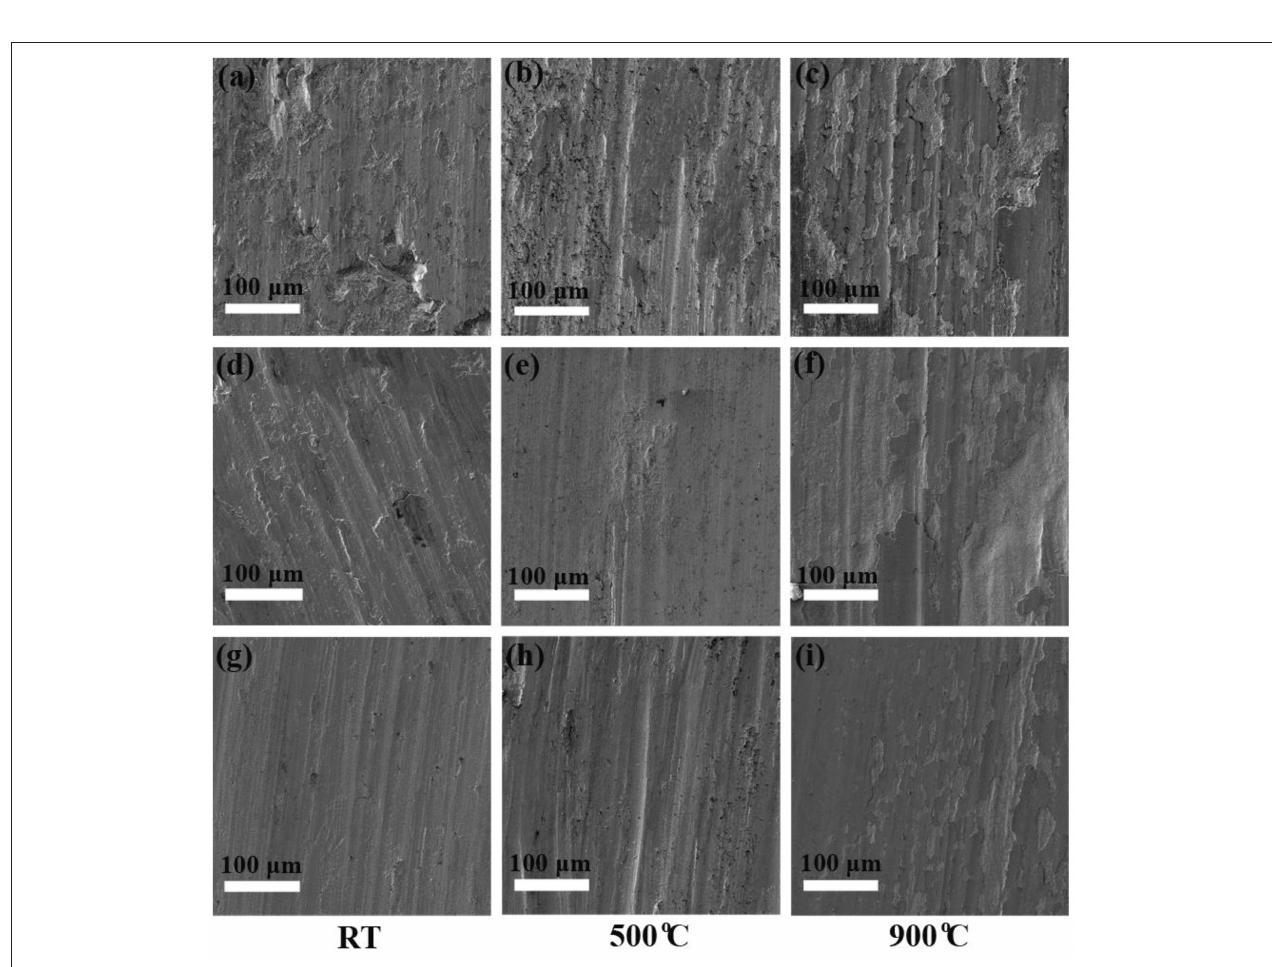
FIGURE 11 | SEM morphologies of worn surfaces of NiCrAlY coating (a–c) as-sprayed, (d–f) 900 ◦ C, and (g–I) 1,100 ◦ C heat treatments at different friction test temperatures.